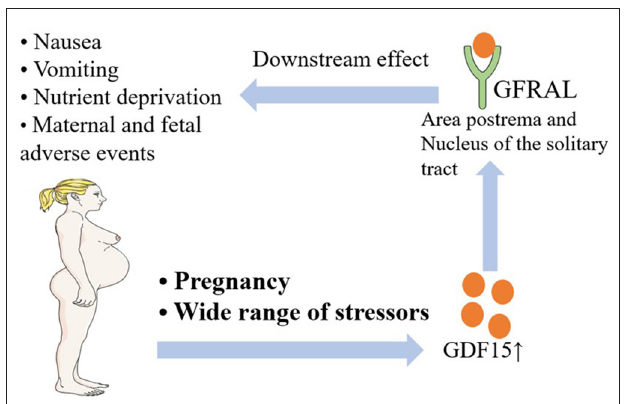
FIGURE 1 | A brief introduction to the relationship between NVP and HG and the GDF15-GFRAL axis. NVP, Nausea and Vomiting of Pregnancy; HG, Hyperemesis Gravidarum; GDF15, Growth/Differentiation Factor 15; GFRAL, Glial-derived neurotrophic factor (GDNF) Family Receptor